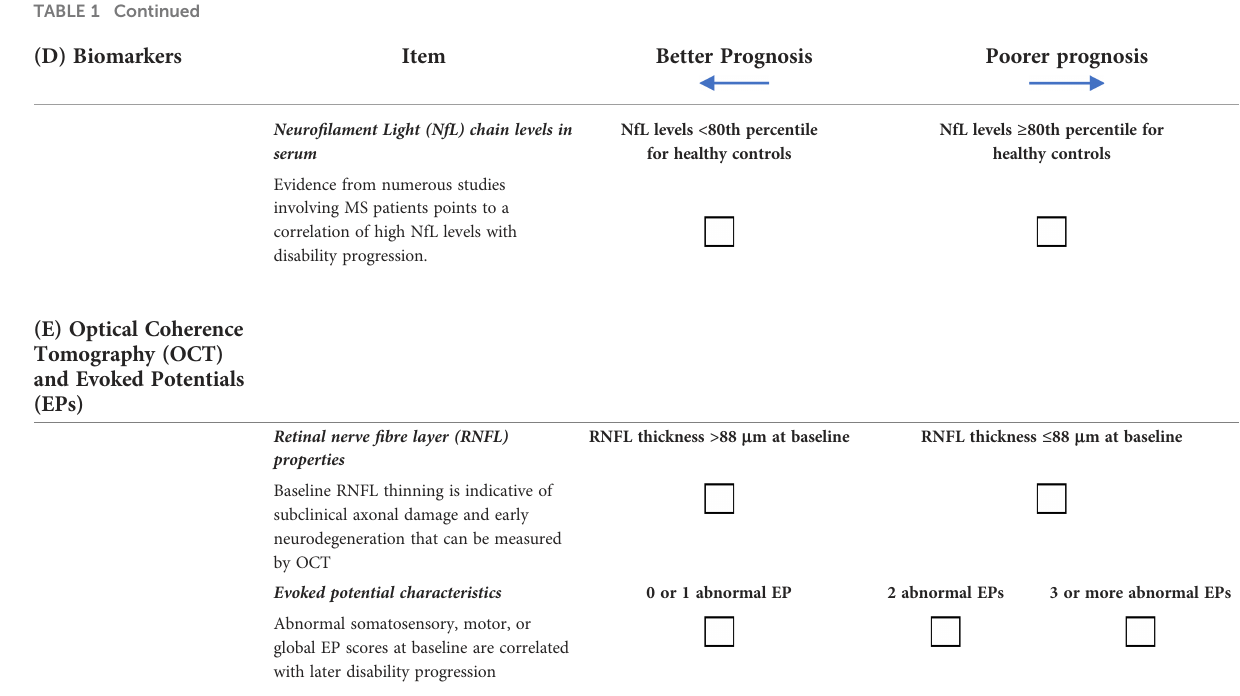
comorbidities. A poorer prognosis will result from the presence of 1, 2, ≥ 3 concomitant comorbidities of increasing weight